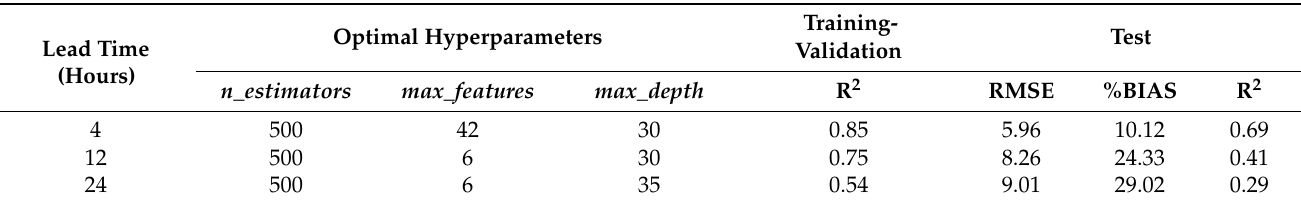
Table 4. Optimal combination of RF hyperparameters for the 4-, 12- and 24-h runoff models and their corresponding performances.